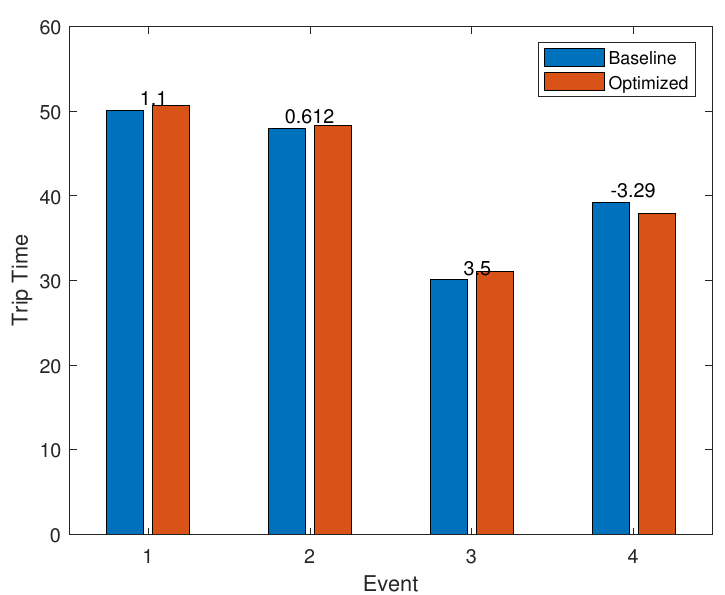
Figure 8. Trip time computed for four events identified in the driving cycle. Numbers on top of each bar are the percentages of trip time loss using our optimization